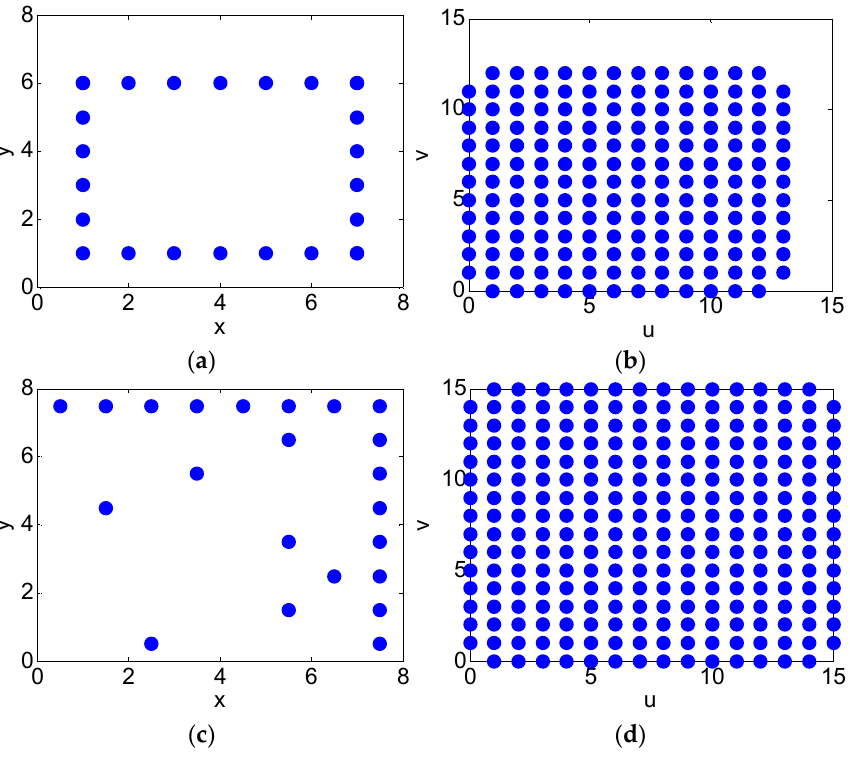
Figure 10. Two types of arrays . ( a ) Rectangular array. ( b ) UV sampling plane of rectangular array. ( c ) L-shaped array. ( d ) UV sampling plane of L-shaped array.